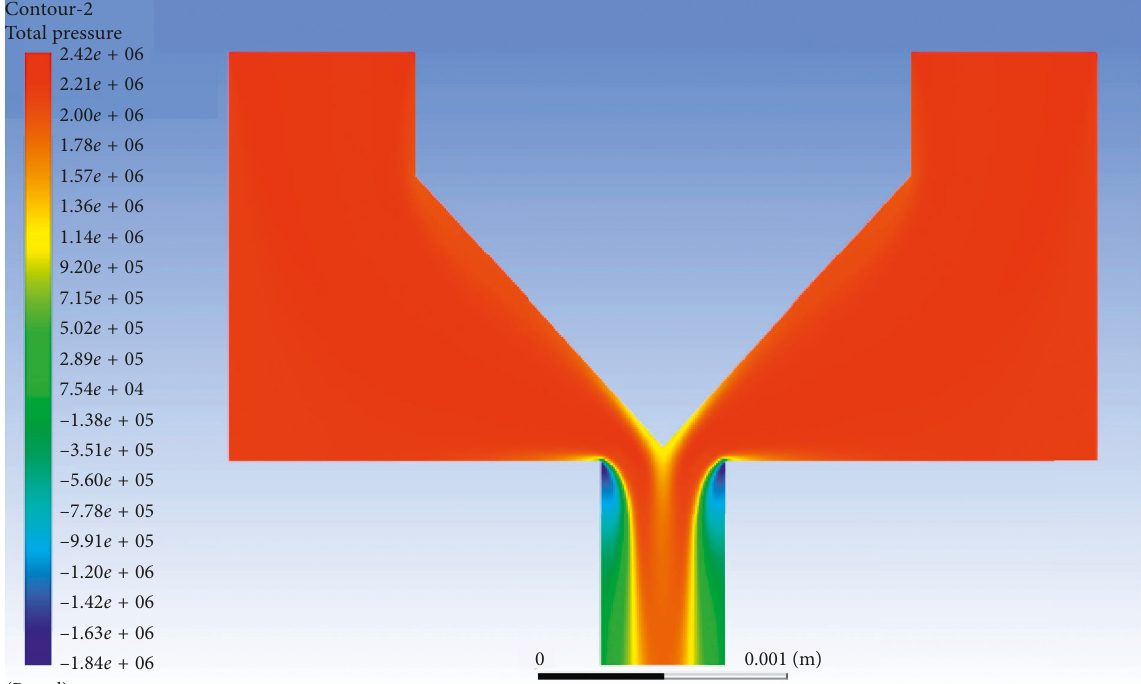
Figure 29: Pressure nephogram of a poppet valve core angle of 90 ° .